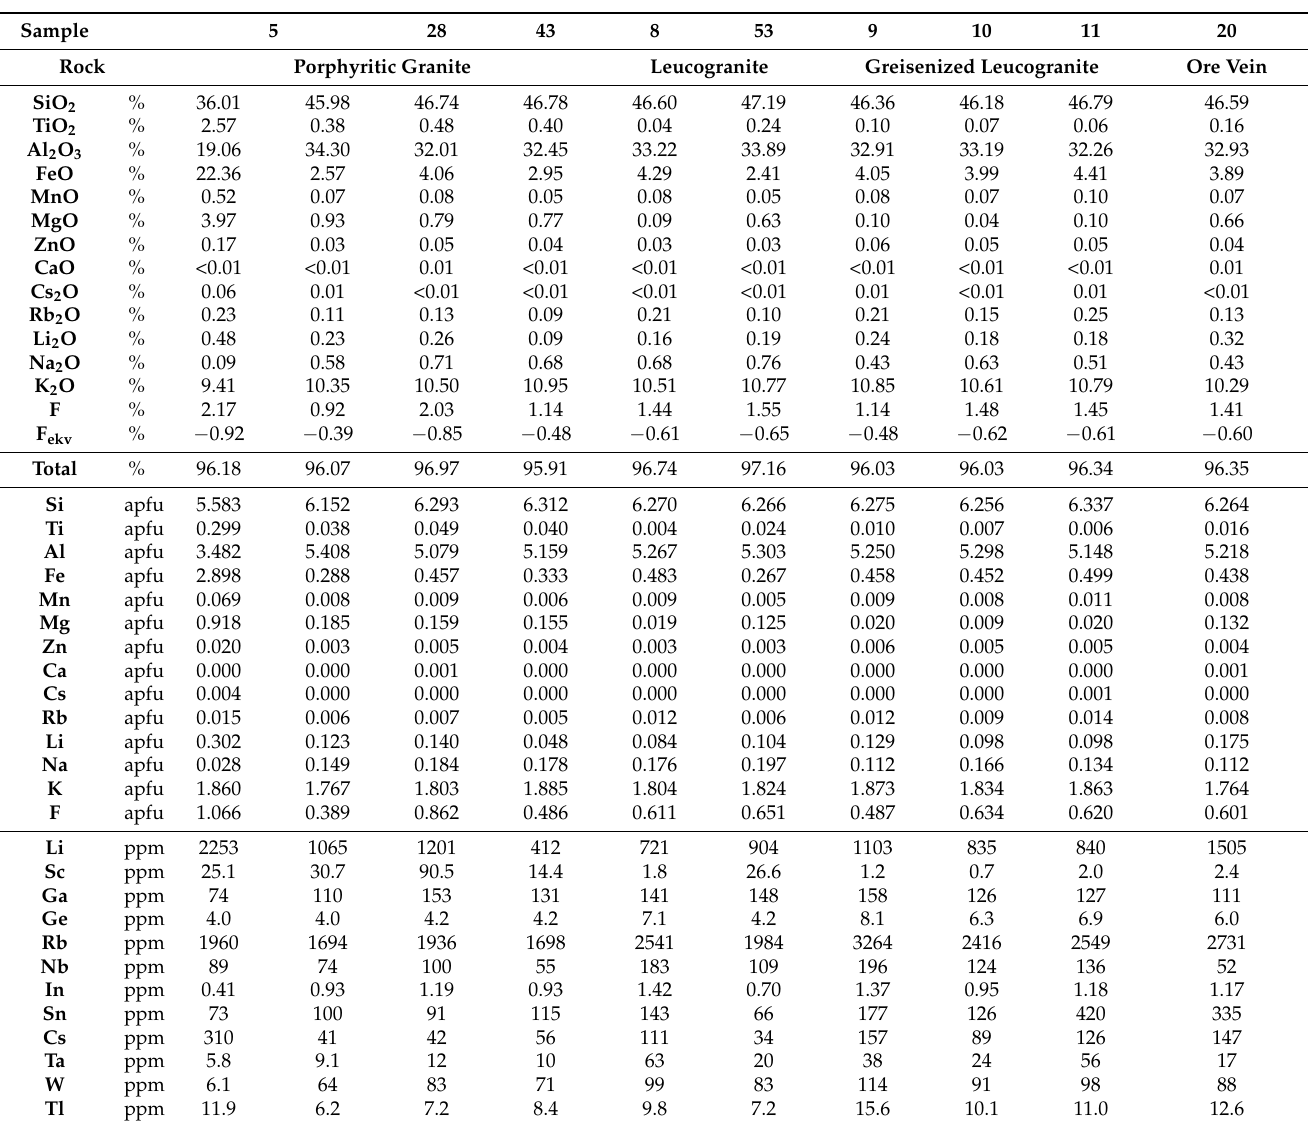
Table 4. Chemical composition (wt.%, EMPA), empirical formulae, and contents of trace elements (ppm, LA-ICP-MS) of micas. Means of 20–25 spot analyses are